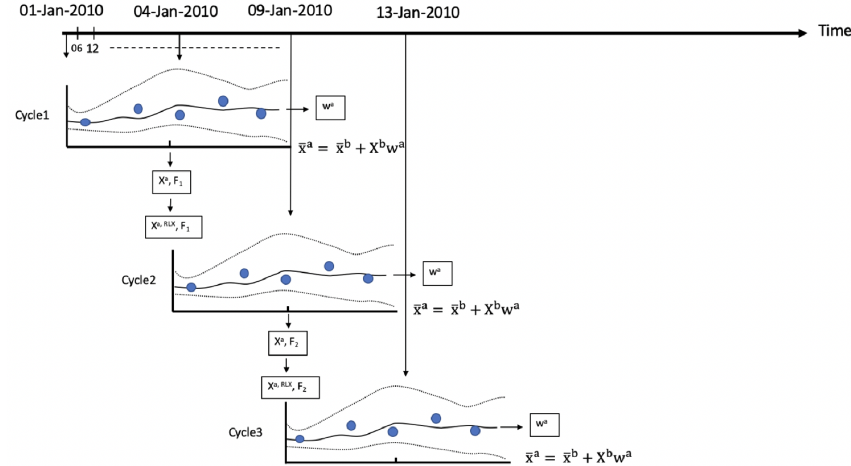
Figure 1. Schematic represents the temporal evolution of the LETKF cycle. In the first assimilation window (Cycle 1), the dotted lines show the ensemble forecast of CH 4 concentrations (with two ensemble members), the solid line shows the linear combination of the forecasts, and the filled circles show the observations of CH 4 concentration. The data assimilation finds the linear combination of the ensemble forecast by estimating the weight ( w a ) that best fits the observations throughout the assimilation window. The analysis weight is applied to obtain optimal surface fluxes ( F ) and the concentration of CH 4 at the intermediate time of the data assimilation window. The updated analyzed concentration ensembles are used as initial conditions after relaxation ( X a , RLX ) (Eq. 8) for the next ensemble forecast. The spread of the ensemble members represents the forecast error. The schematic is adapted from Kalnay and Yang (2010) and Miyazaki et al.